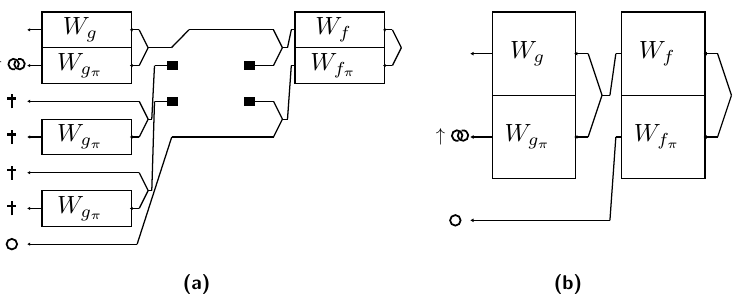
Figure 10: (a) shows the vulnerability profile of a composition of two functions when a register is considered in the middle. Probes that come after the "circuit breaker" map to the unit of Vect and thus do not add any information so they have been drawn with a R white circle. The Fourier transform of the output distribution is isomorphic to the one produced by the diagram in